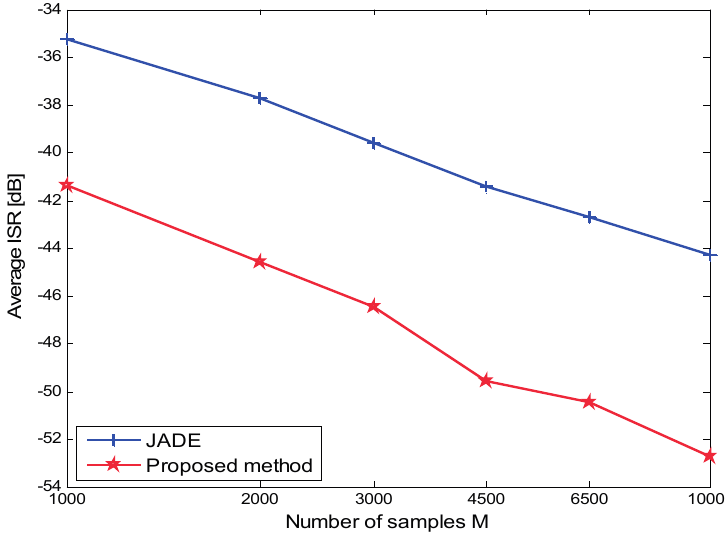
Figure 2. ISR performance comparison of JADE and the proposed method.